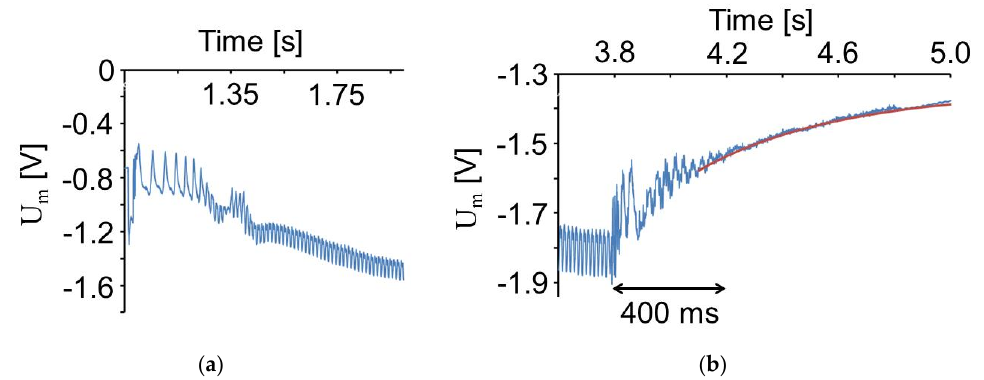
Figure 20. Voltage measured as shown in Figure 18 in the time range of start ( a ) and end ( b ) of ma- chine movements. The curve adapted to the data according to Equation (11) is shown in ( b